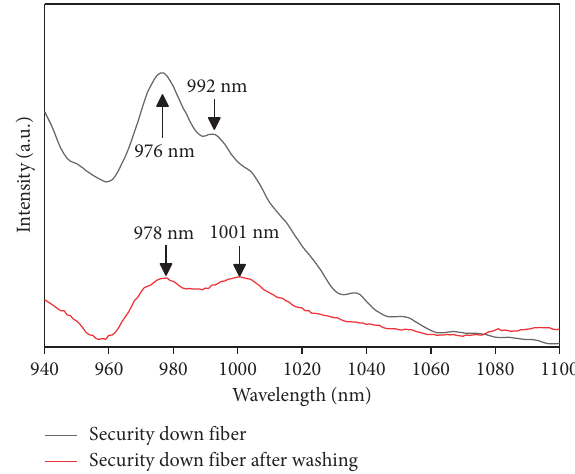
Figure 7: PL spectra of security down fiber upon 900nm